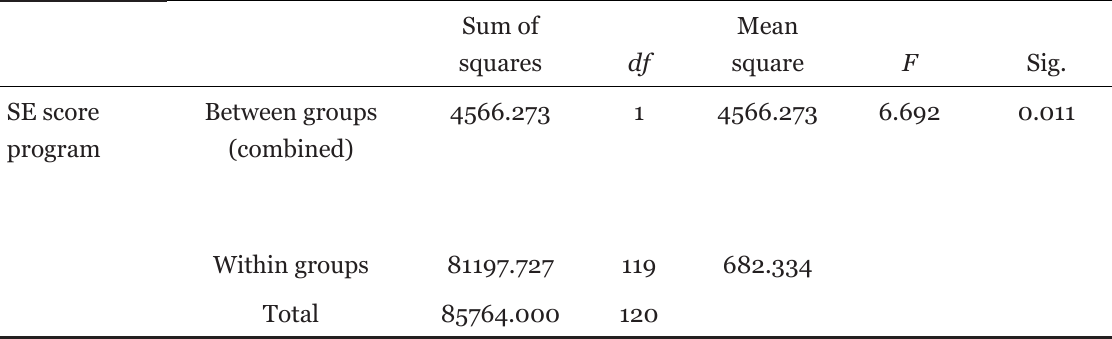
Self-Efficacy (SE) Scores by Program: ANOVA Results